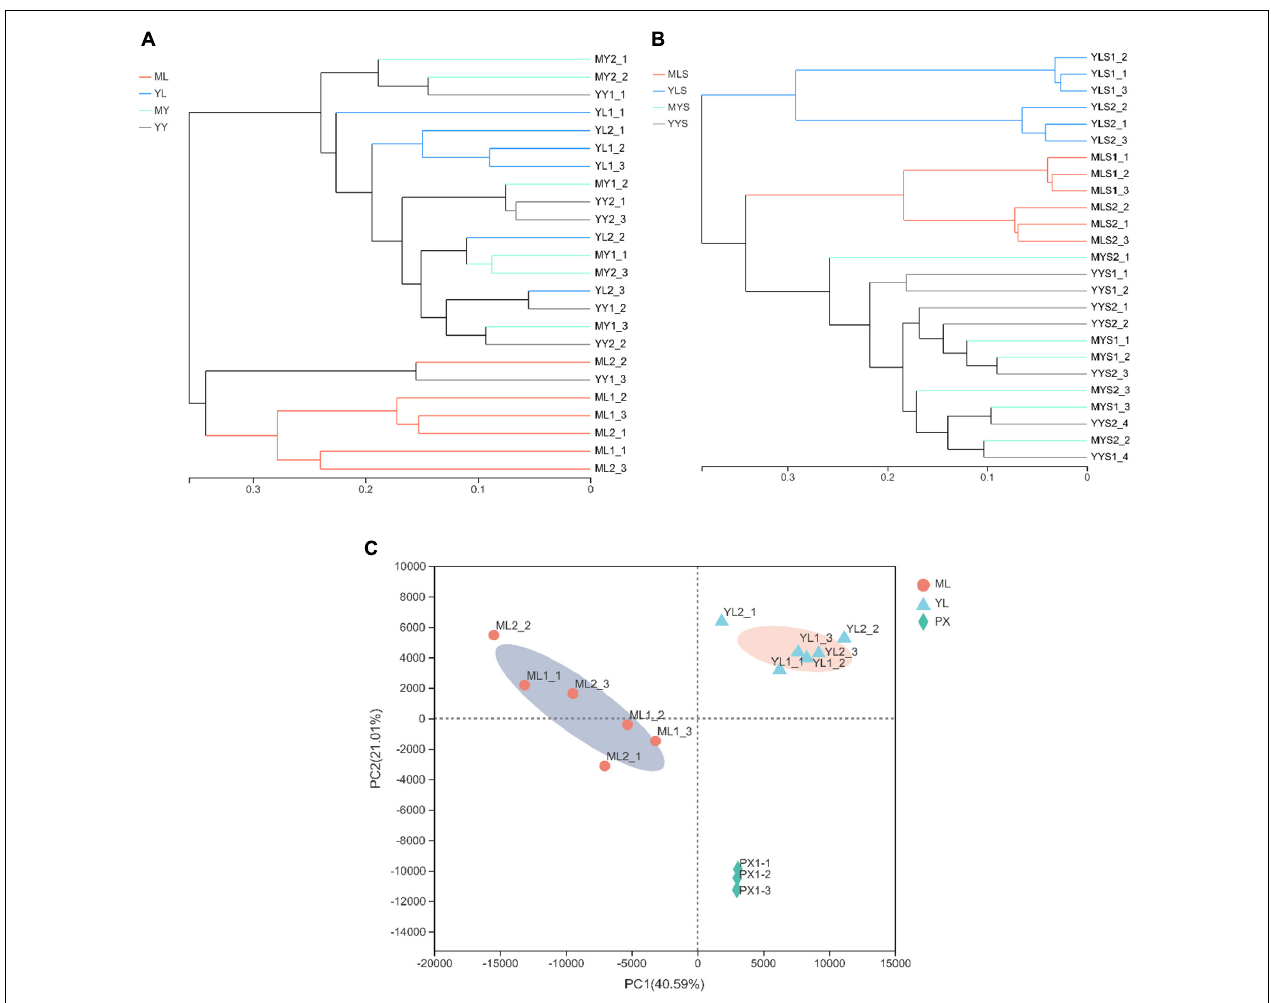
FIGURE 9 | Hierarchical clustering diagram of cultivating Lingzi in the mountains. (A) Refers to the hierarchical clustering diagram of plant samples under two cultivation modes; (B) refers to the hierarchical clustering diagram of soil samples under two cultivation modes; (C) refers to the PCA